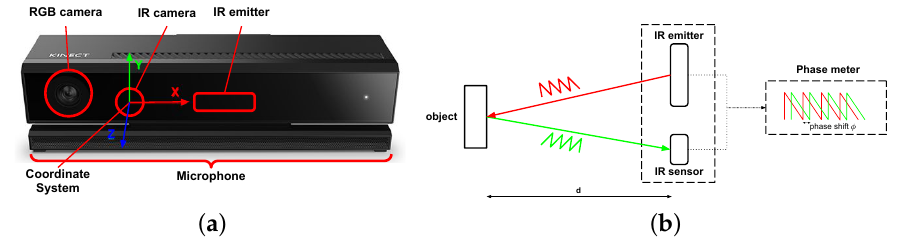
Figure 4. ( a ) The coordinate system of the Kinect v2 camera and the location of the sensors [15]; ( b ) time-of-flight (ToF) principle used in the Kinect sensor. The sent and received signal are compared to each other in order to determine the phase change and calculate the